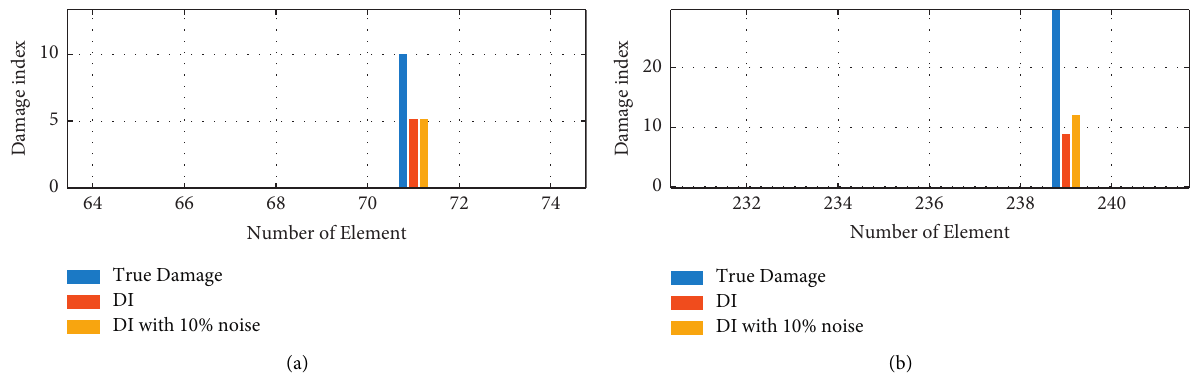
Figure 20: Results of damage scenario D5 containing 10% measurement noise using only first 3 modes. (a) Zoomed result part 1. (b) Zoomed result part 2.